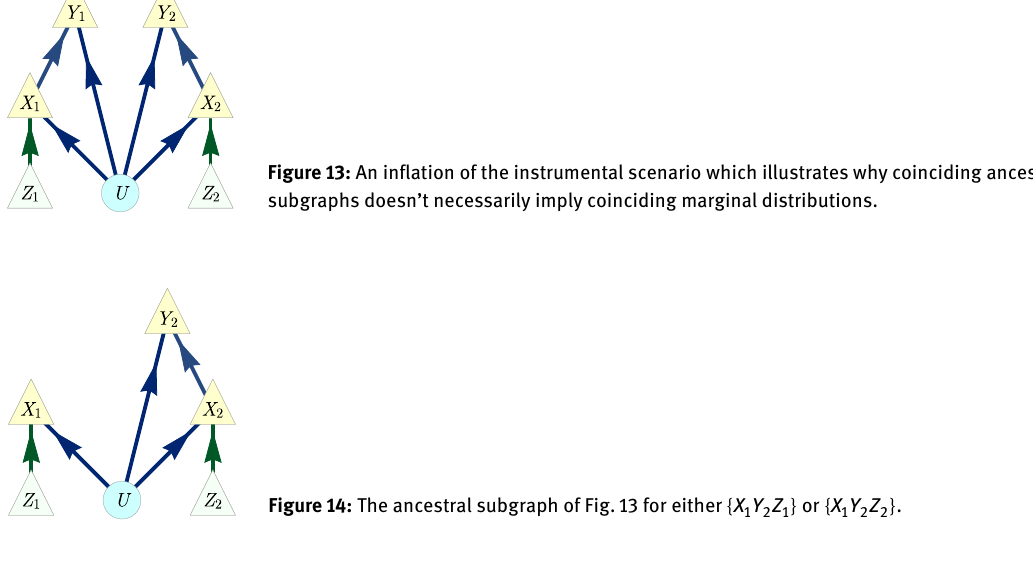
Figure 13: An inflation of the instrumental scenario which illustrates why coinciding ancestral subgraphs doesn’t necessarily imply coinciding marginal distributions.